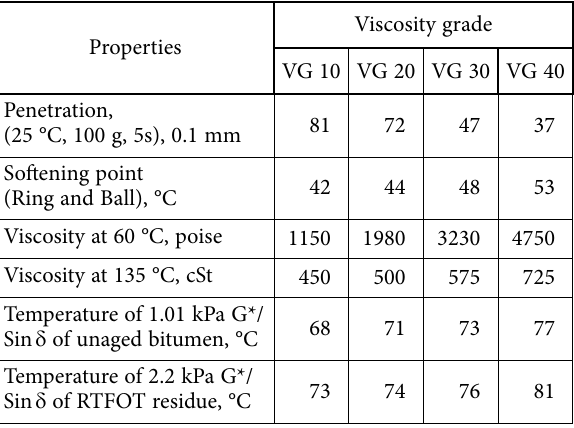
Table 2. Properties of virgin bitumen